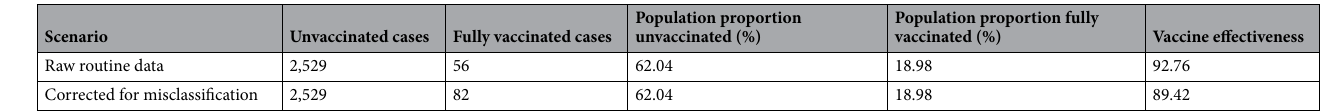
Table 2. Vaccine effectiveness determined with Farrington’s screening method 9 and input data for